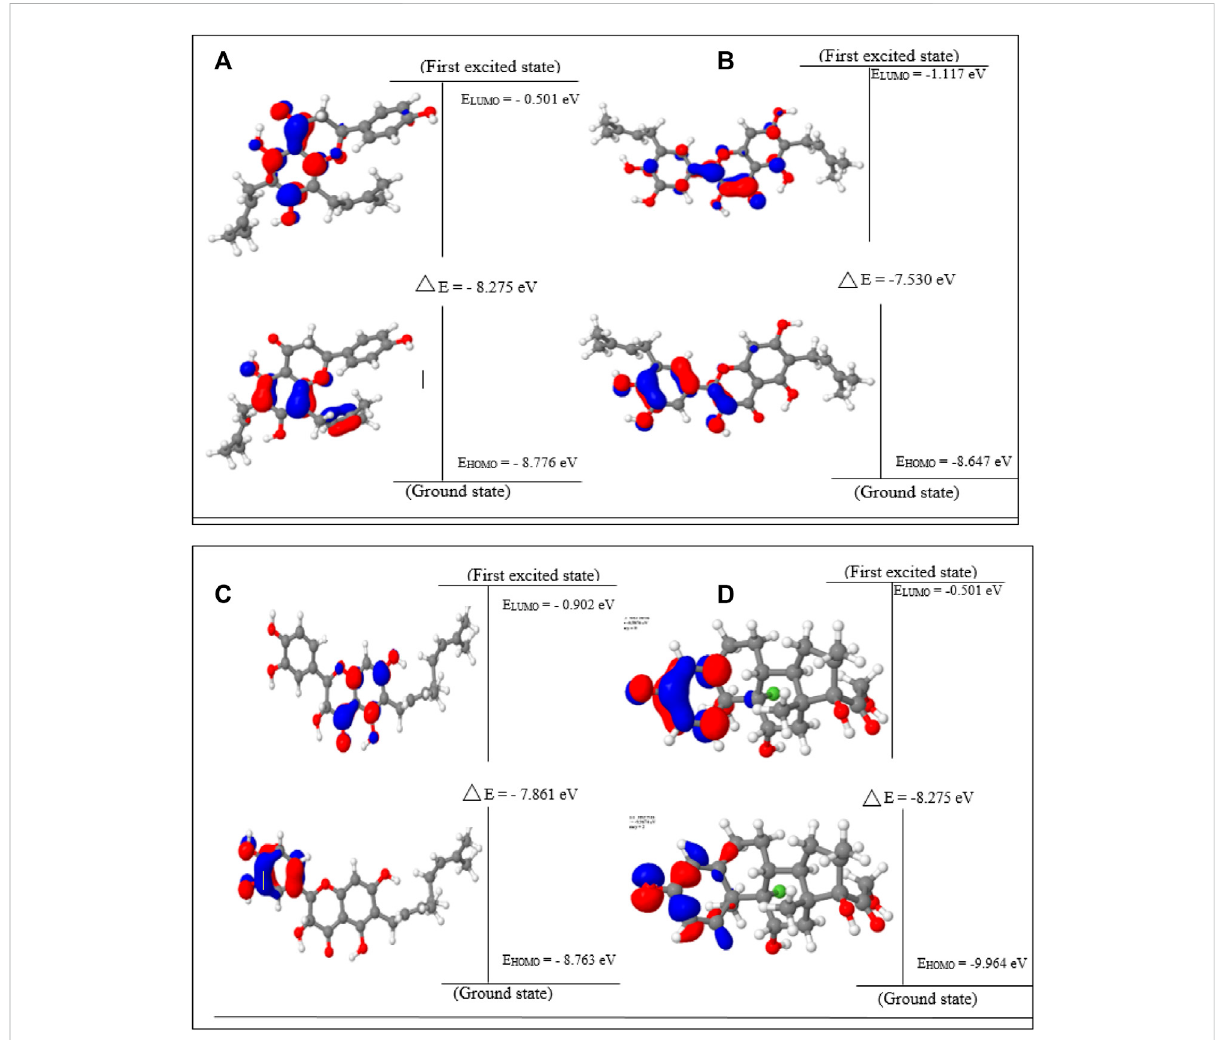
FIGURE 1 HOMO, LUMO, and band gap energy ( Δ E) of the top four compounds: (A) lonchocarpol A, (B) broussonol E, (C) diplacol, (D) dexamethasone.